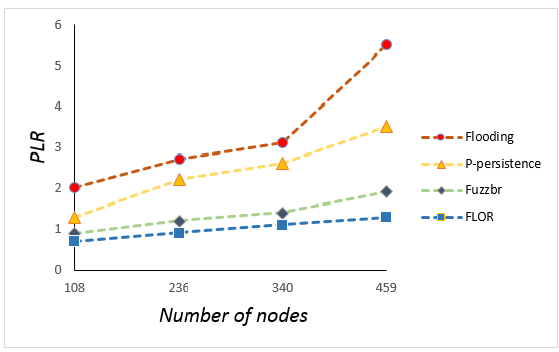
Figure 9. PLR for different numbers of vehicles.